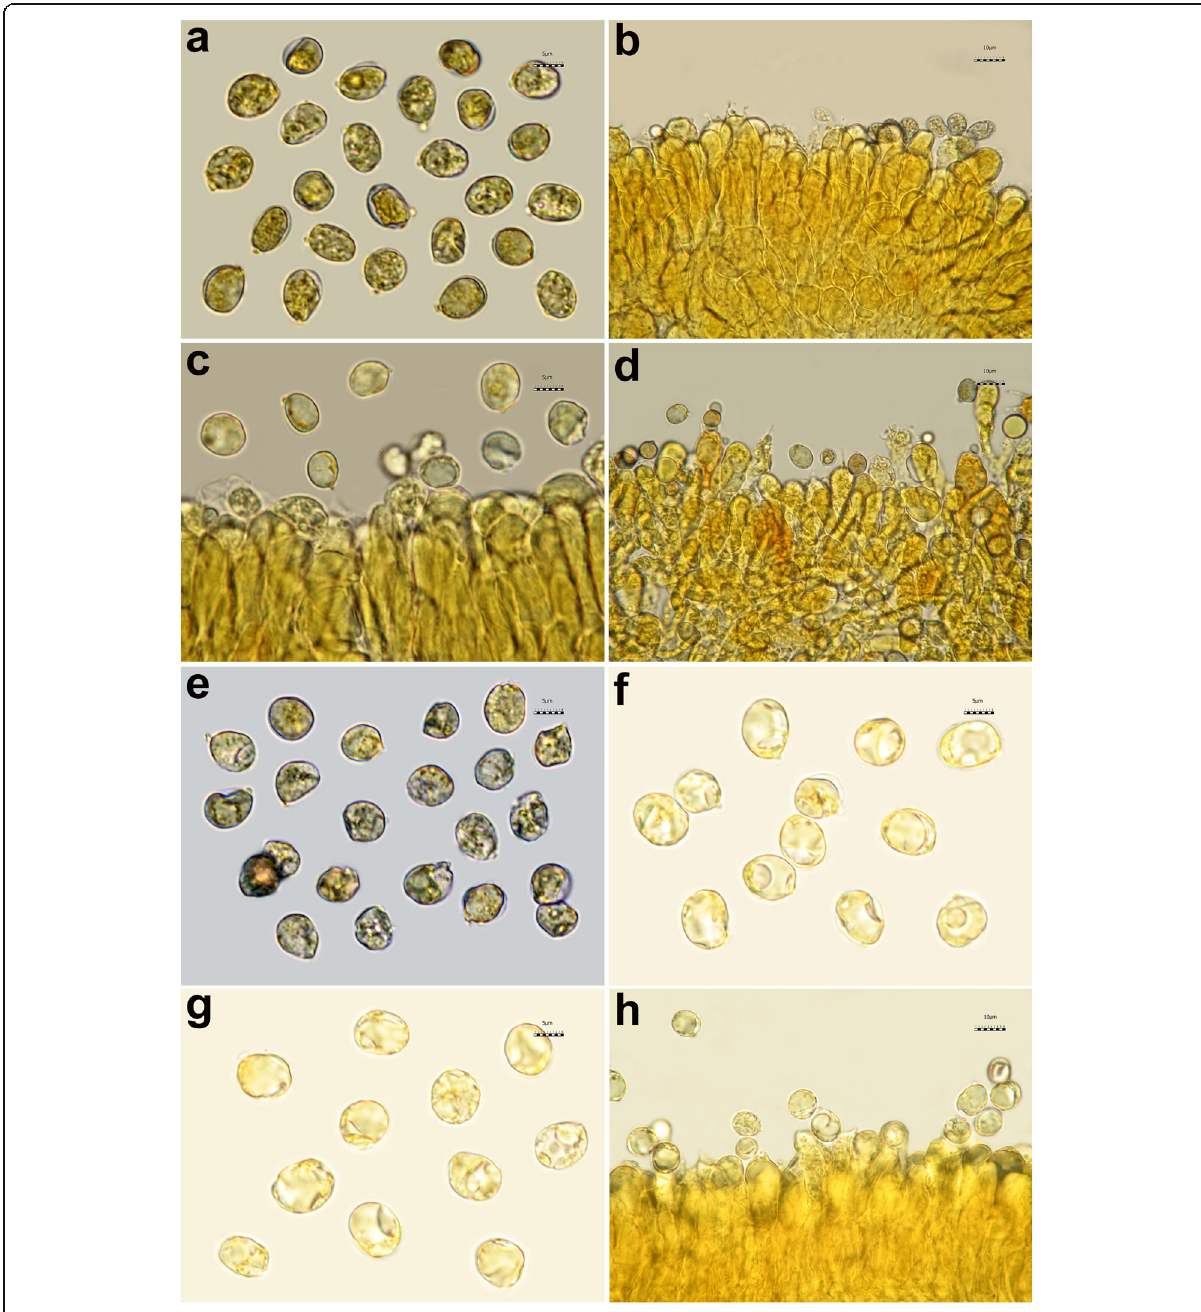
Fig. 7 Spores and basidia of Amanita phalloides ( a – e, AMB 18719) and A. argentea ( f – h , AMB 18720). a – c , f Observed in Melzer ’ s without pre- heating, immediately after squashing ( a soaked in tap water, b , f in 5% ammonia and c in 5% potassium hydroxide). d – g Observed in Melzer ’ s without pre-heating after leaving the sample in Melzer ’ s for 30 min (soaked in 5% ammonia). e – h Observed in Melzer ’ s with pre-heating. Photos by L.